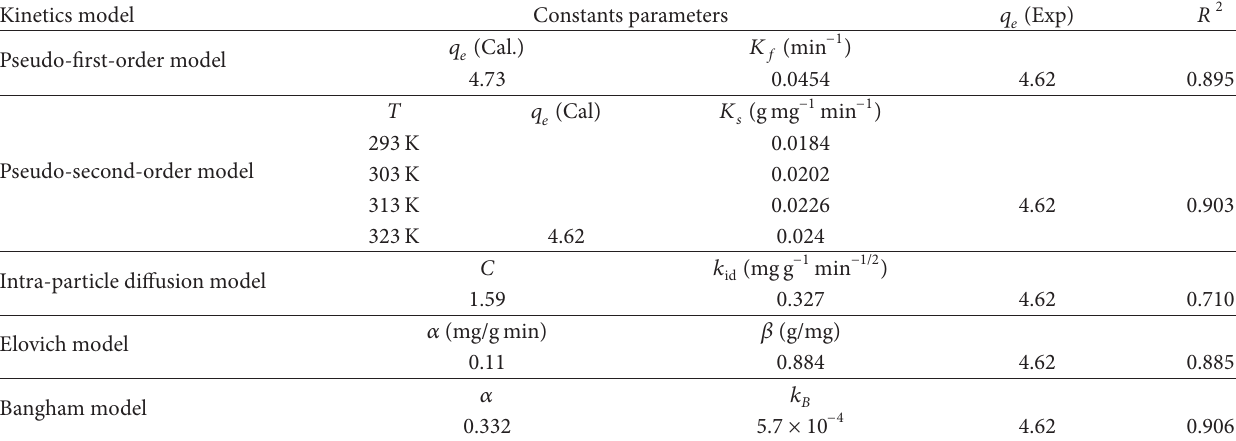
T 2: Kinetics parameters for sorption of Co(II) on